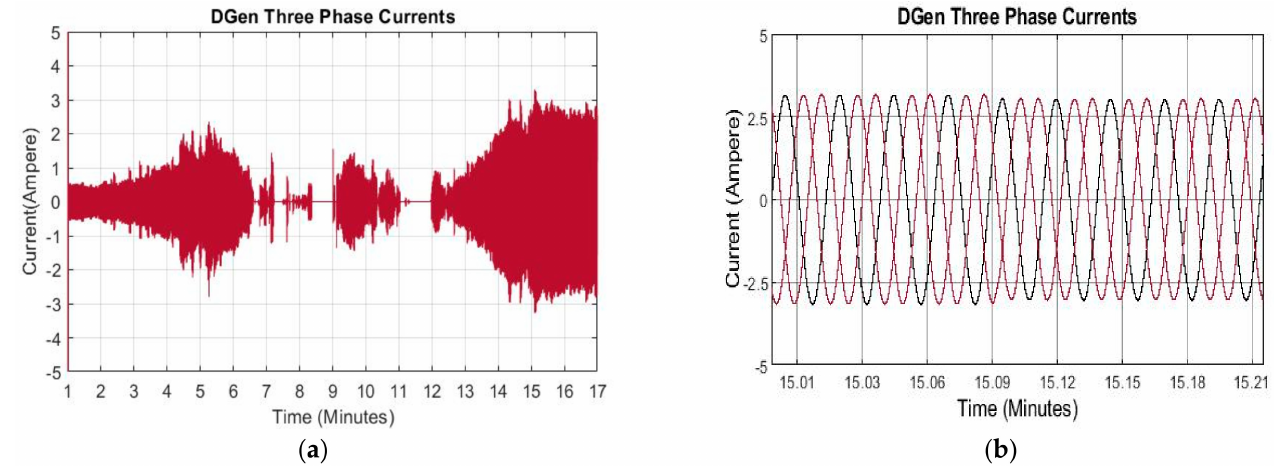
Figure 19. ( a ) Diesel generator three phase currents; ( b ) Zoom in view of